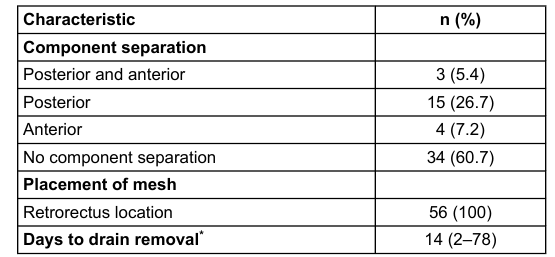
Table 3: Operative characteristics (n =